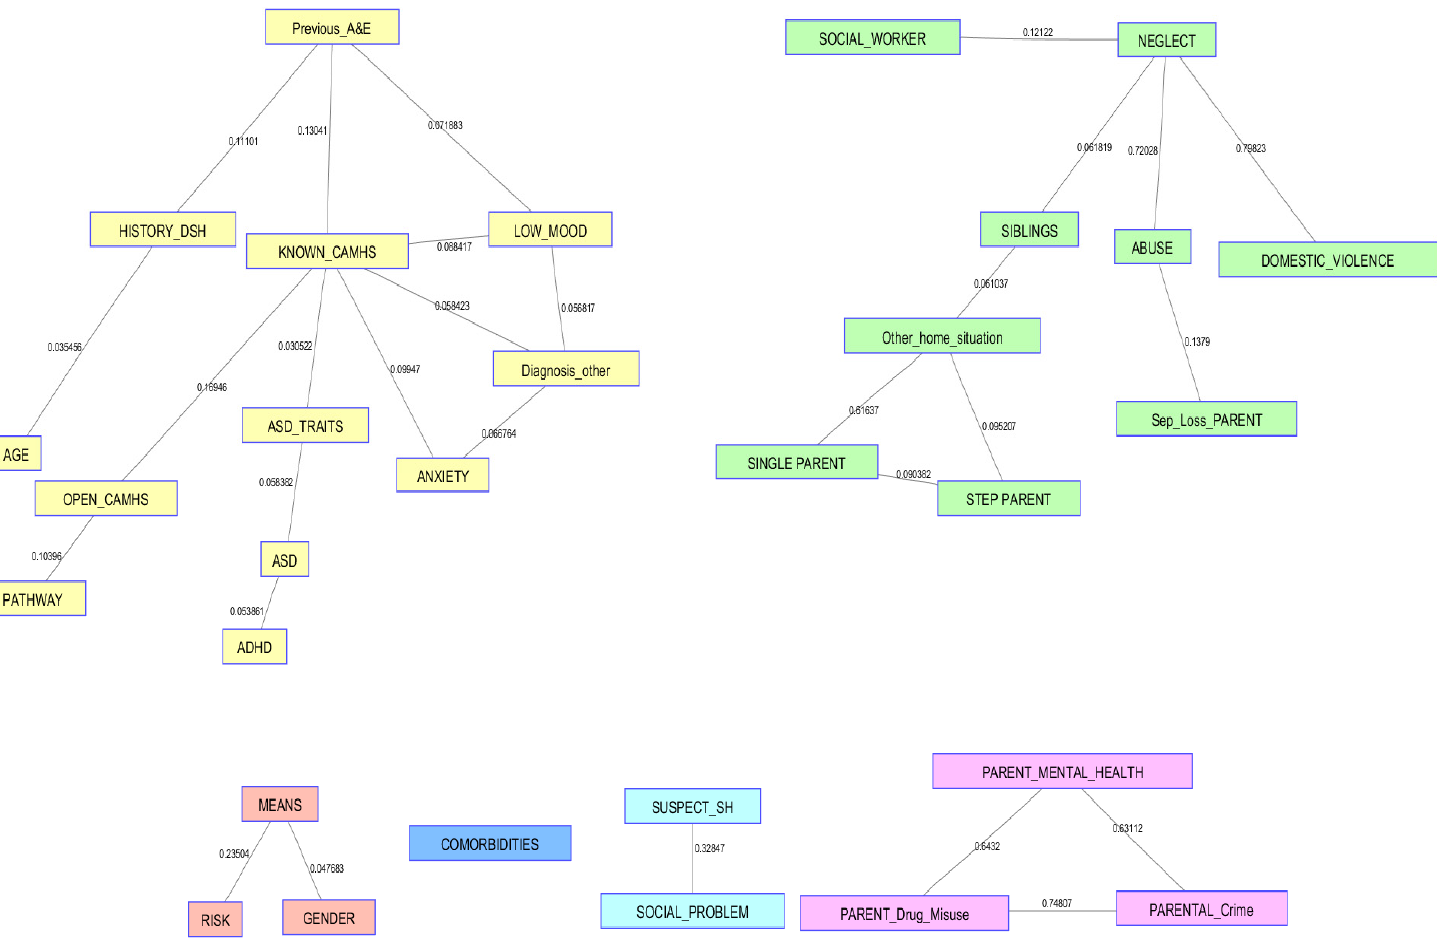
Figure 1. Figure 1. CI-Map.